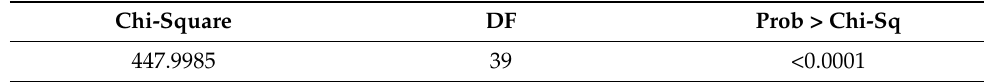
Table 2. Kruskal–Wallis